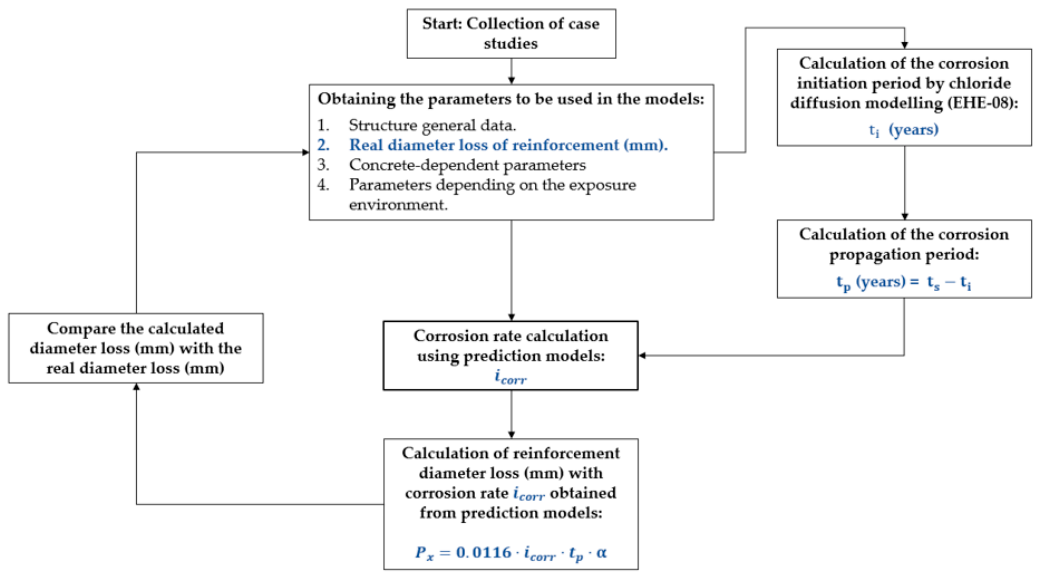
Figure 2. General methodology flowchart to calculate the diameter loss with the proposed corrosion prediction models and validation using real study